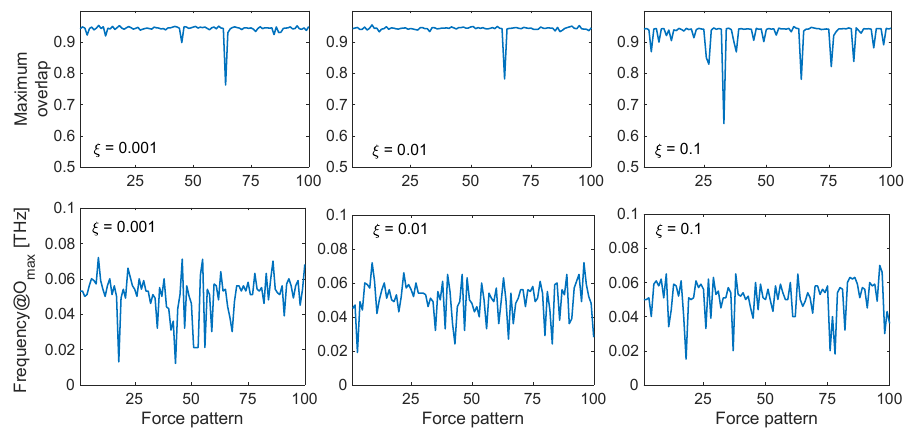
Figure 7. Maximum overlap score and corresponding applied frequency f F for the LAO-binding protein conformational change, as a function of damping ( ξ = 0.001, 0.01, 0.1) and specific random force pattern. The maximum overlap values, shown in the upper panels, are defined as the maximum values obtained over all the applied frequencies in the range 0.001–0.5 THz, and the corresponding optimal frequencies are reported in the lower panels depending on each of the 100 random force patterns.